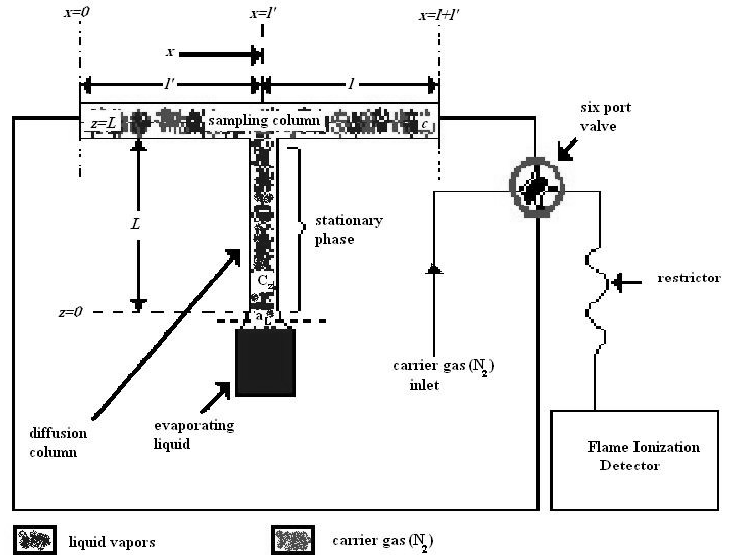
Figure 1 . Schematic arrangement showing the diffusion column L connected to the chromatographic column l + l’ and carrier gas flows from D